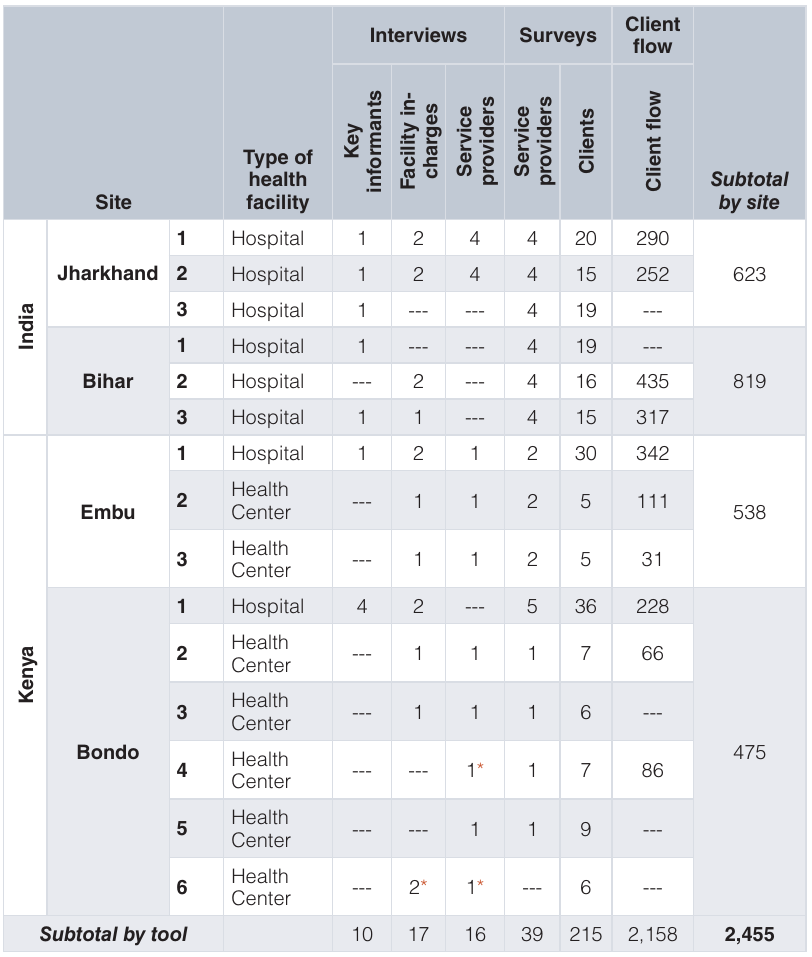
Table 1. Description of sample population by source location and data collection